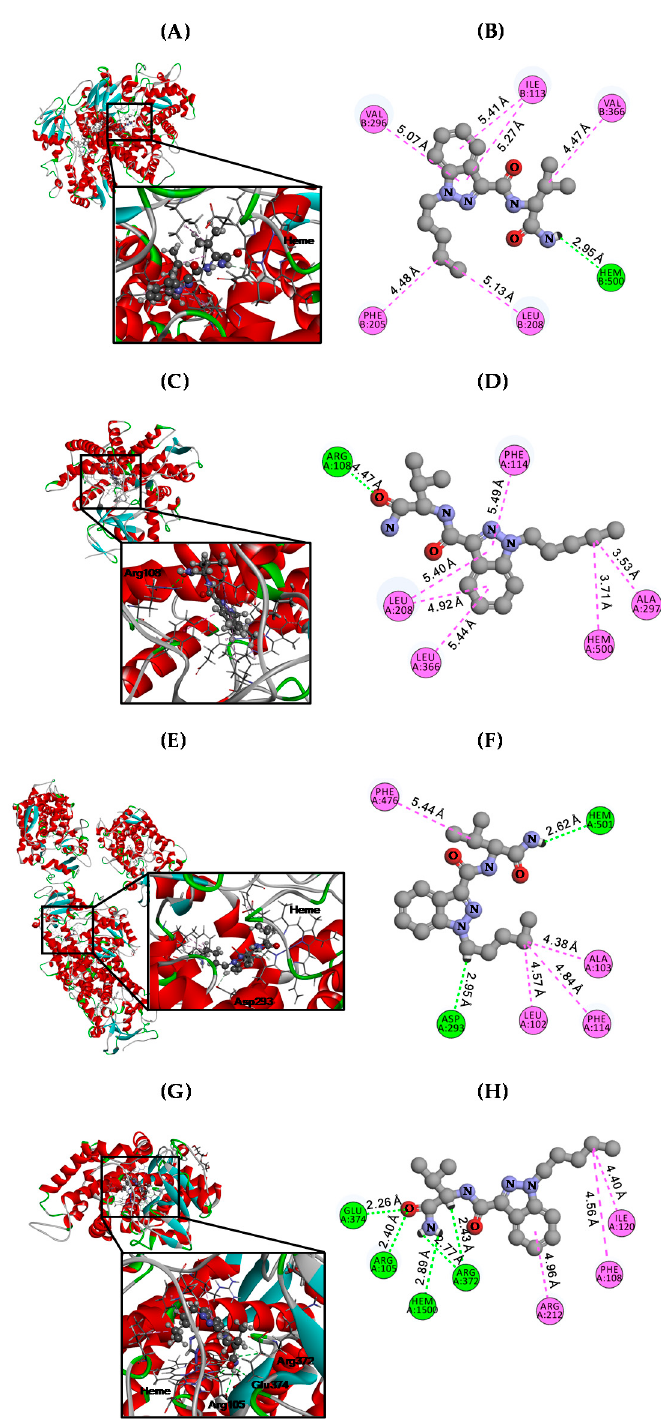
Figure 7. Structural docking analysis of AB-PINACA with CYP2C8 ( A , B ), CYP2C9 ( C , D ), CYP2C19 ( E , F ), and CYP3A4 ( G , H ). Mechanisms of molecular action of AB-PINACA with each CYP are shown in 3D structures ( A , C , E , G ) and 2D plots ( B , D , F , H ). The favorable binding of AB-PINACA to the active pocket of each CYP is shown in 3D structures. The hydrogen bonds and hydrophobic interactions between AB-PINACA and each of the CYPs are shown in 2D plots. The docking scores (kcal/mol) are summarized in Table 3. Green, hydrogen bonds; pink, hydrophobic interactions.